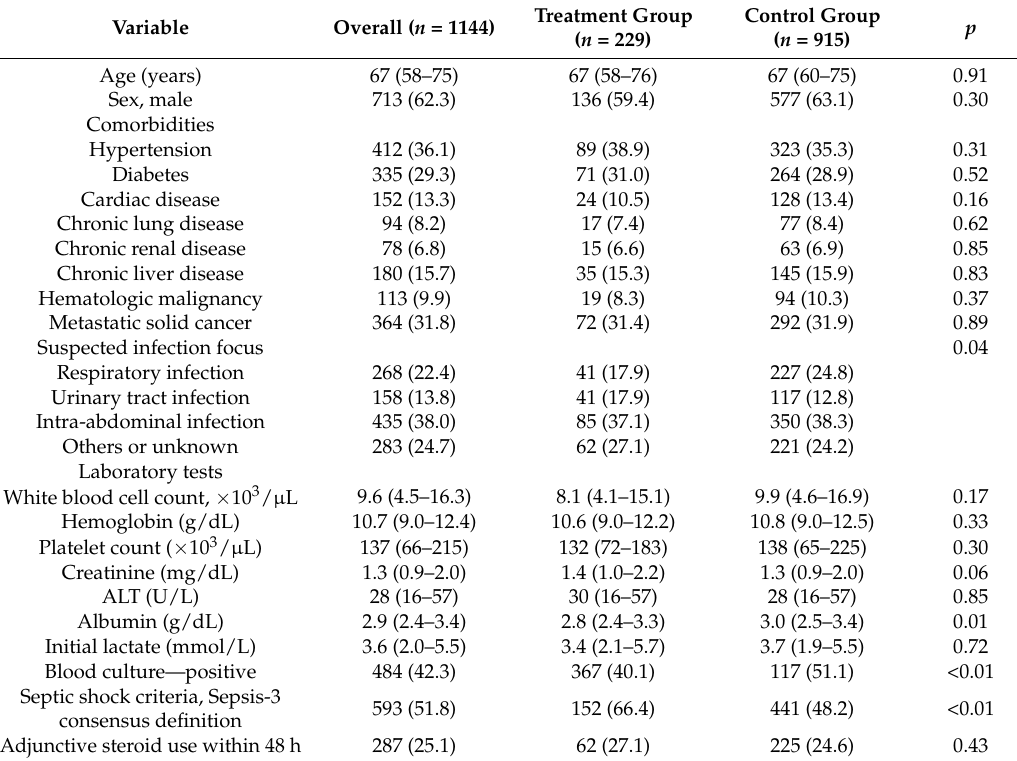
Table 1. Baseline characteristics of the unmatched